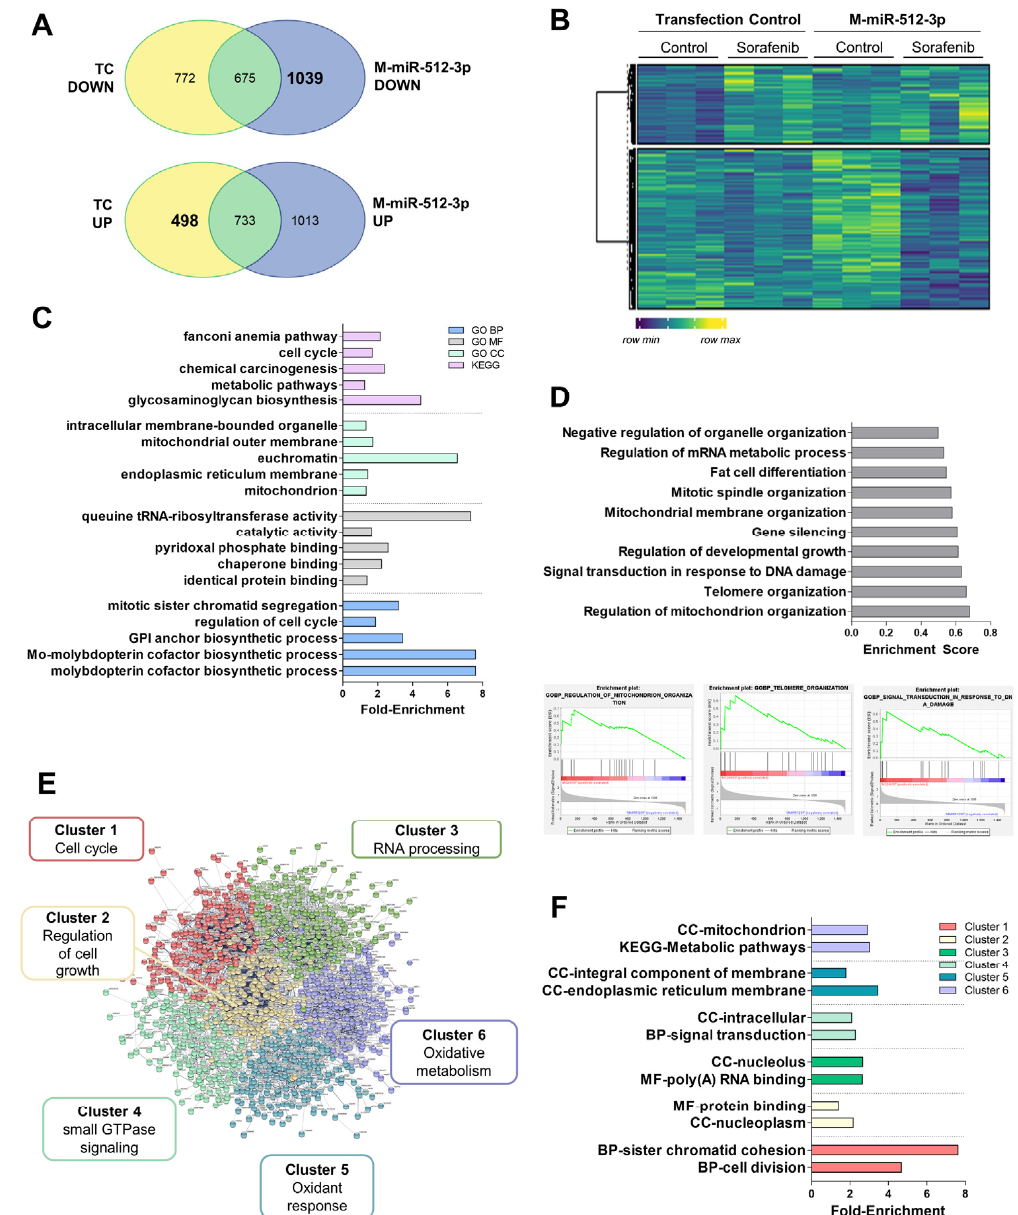
Figure 8. RNA-sequencing data of miR-512-3p overexpression in the HepG2 cells showed reduced oxidative metabolism. ( A ) Venn diagrams showing mRNAs regulated upon miR-512-3p mimics (M- miR-512-3p) compared to the transfection control (TC). ( B )Heatmap of genes regulated by miR-512- 3p. ( C ) Fold-enrichment values of the top five most significantly enriched GO BP, MF, CC, and KEGG pathways. ( D )Top 10 significant hallmarks of GSEA downregulated after M-miR-222-5p. Plots were provided for the three most enriched terms. ( E )Diagram showing the clustering of STRING analysis. ( F ) Fold-enrichment values of the top two most significantly enriched terms either